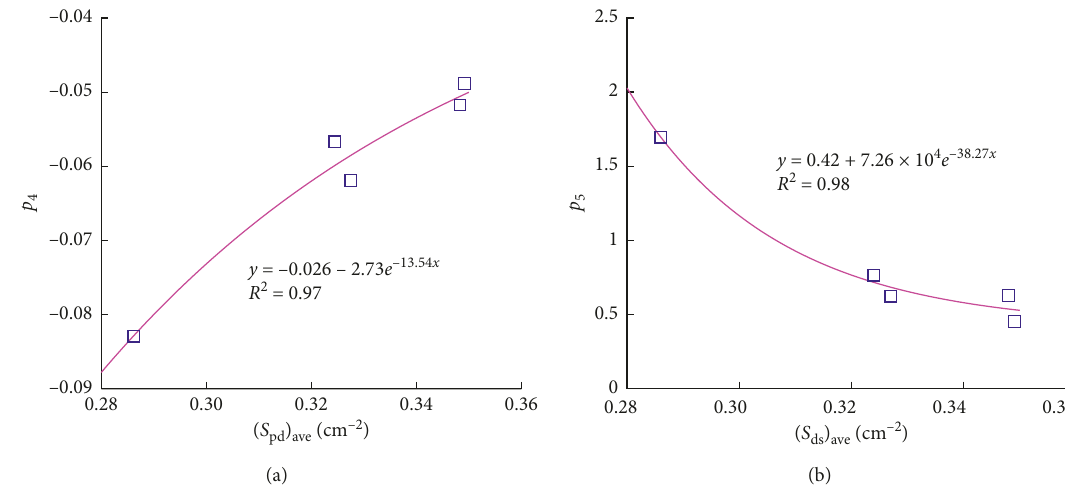
Figure 7: Relationship between fitting parameters p 4 , p 5, and ( S pd ) ave . (a) p 4 vs ( S pd ) ave ; (b) p 5 vs ( S pd ) ave